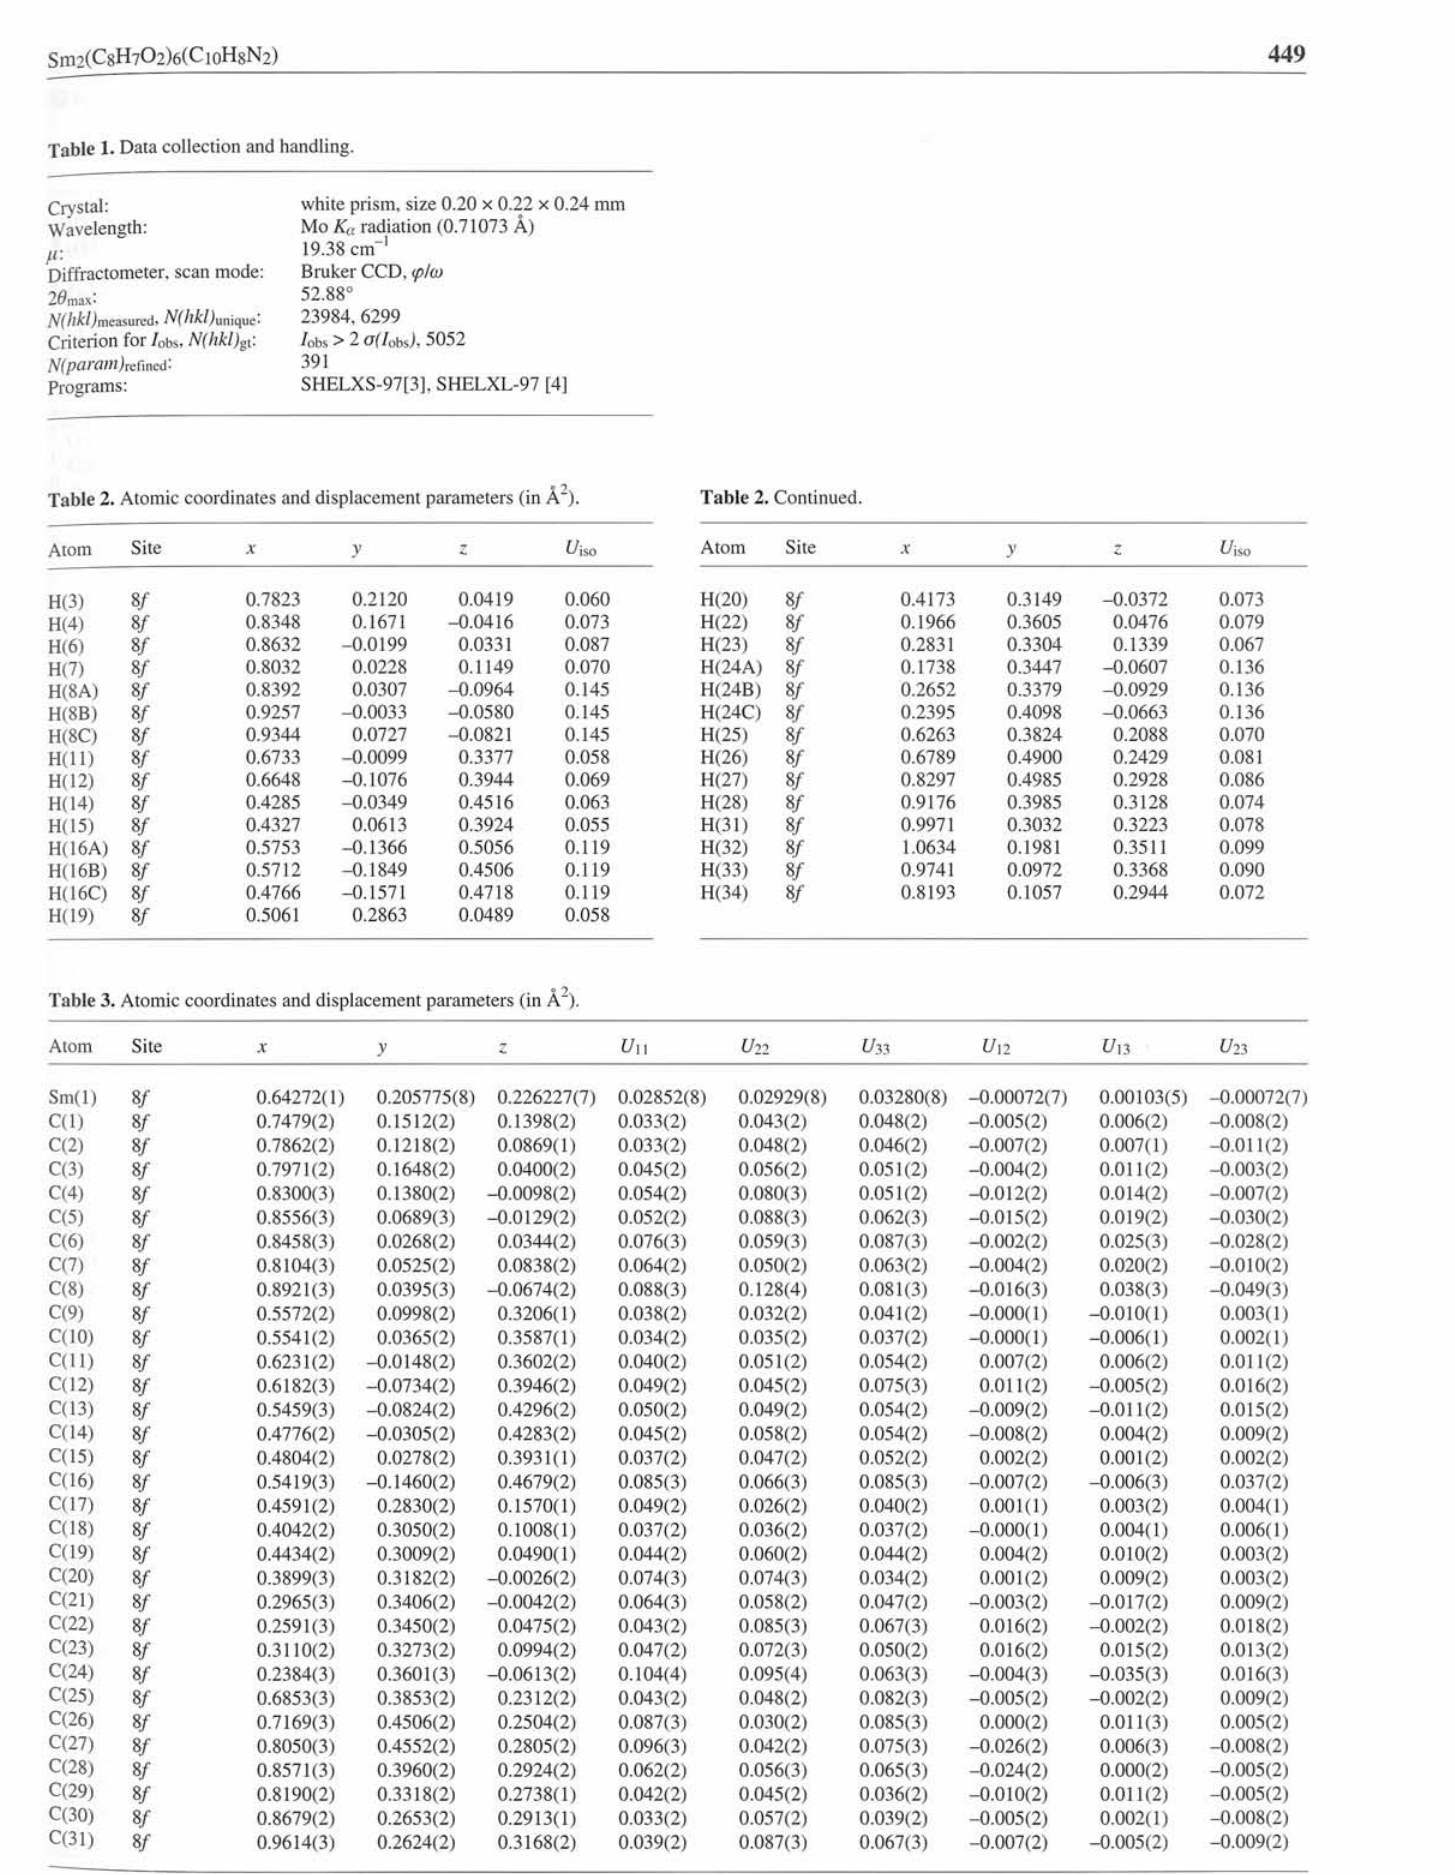
ο η Table 3. Atomic coordinates and displacement parameters (in